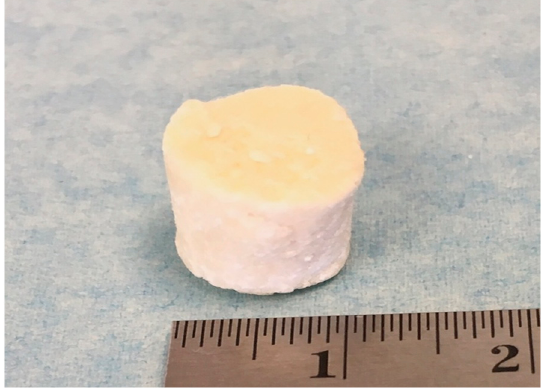
Figure 6. Experimental chewing gums produced, weighing 1.0 g and composed as described in Table 2.